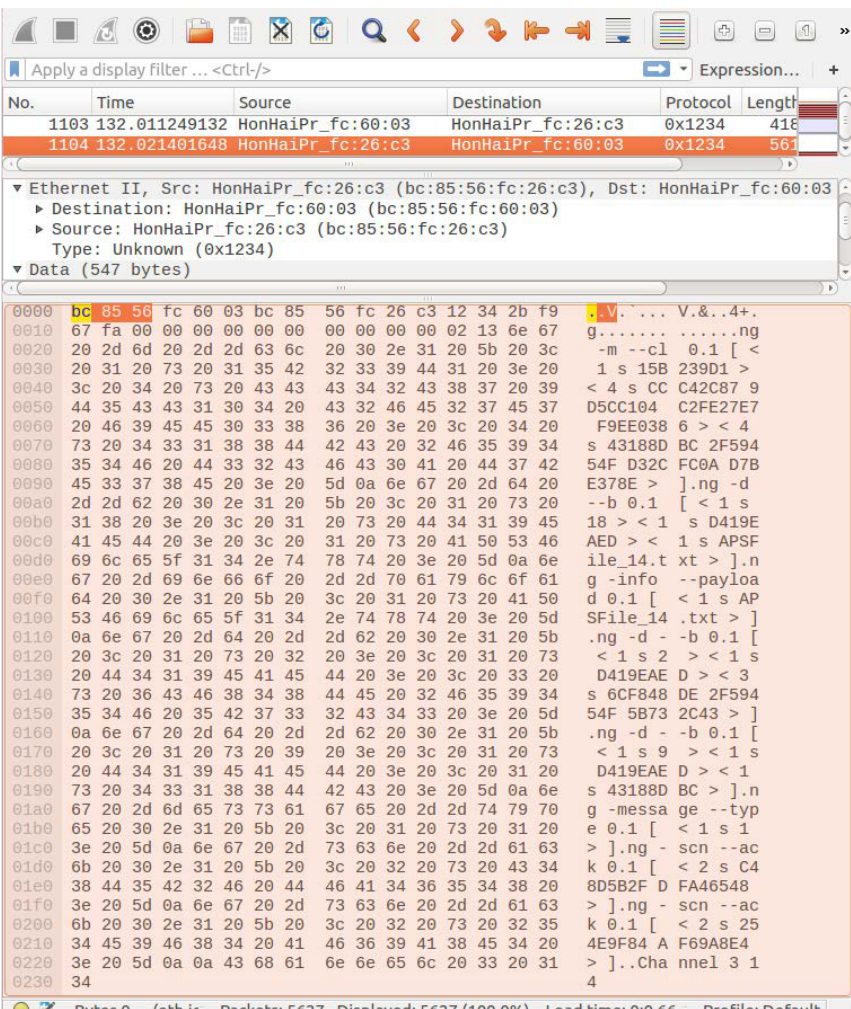
Figure 17. Capture of a NG message from RMS to APS using Wireshark TM